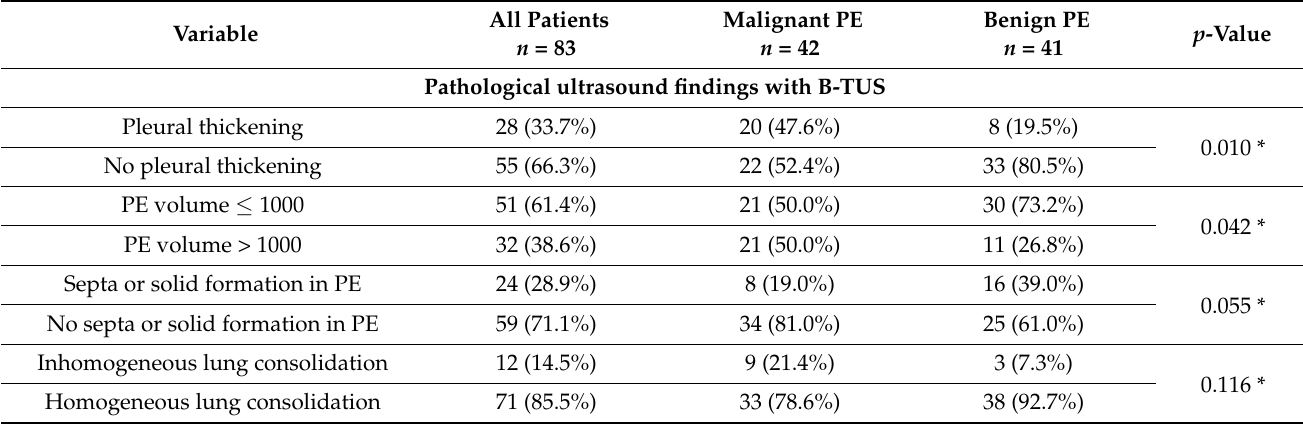
Table 2. B-TUS data of the n = 83 patients, subdivided between final malignant and benign PE. Variable